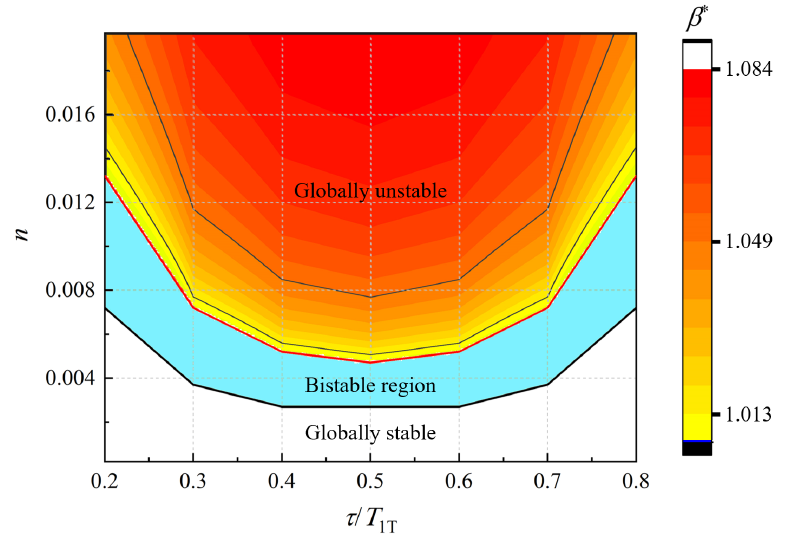
Figure 13. The region of